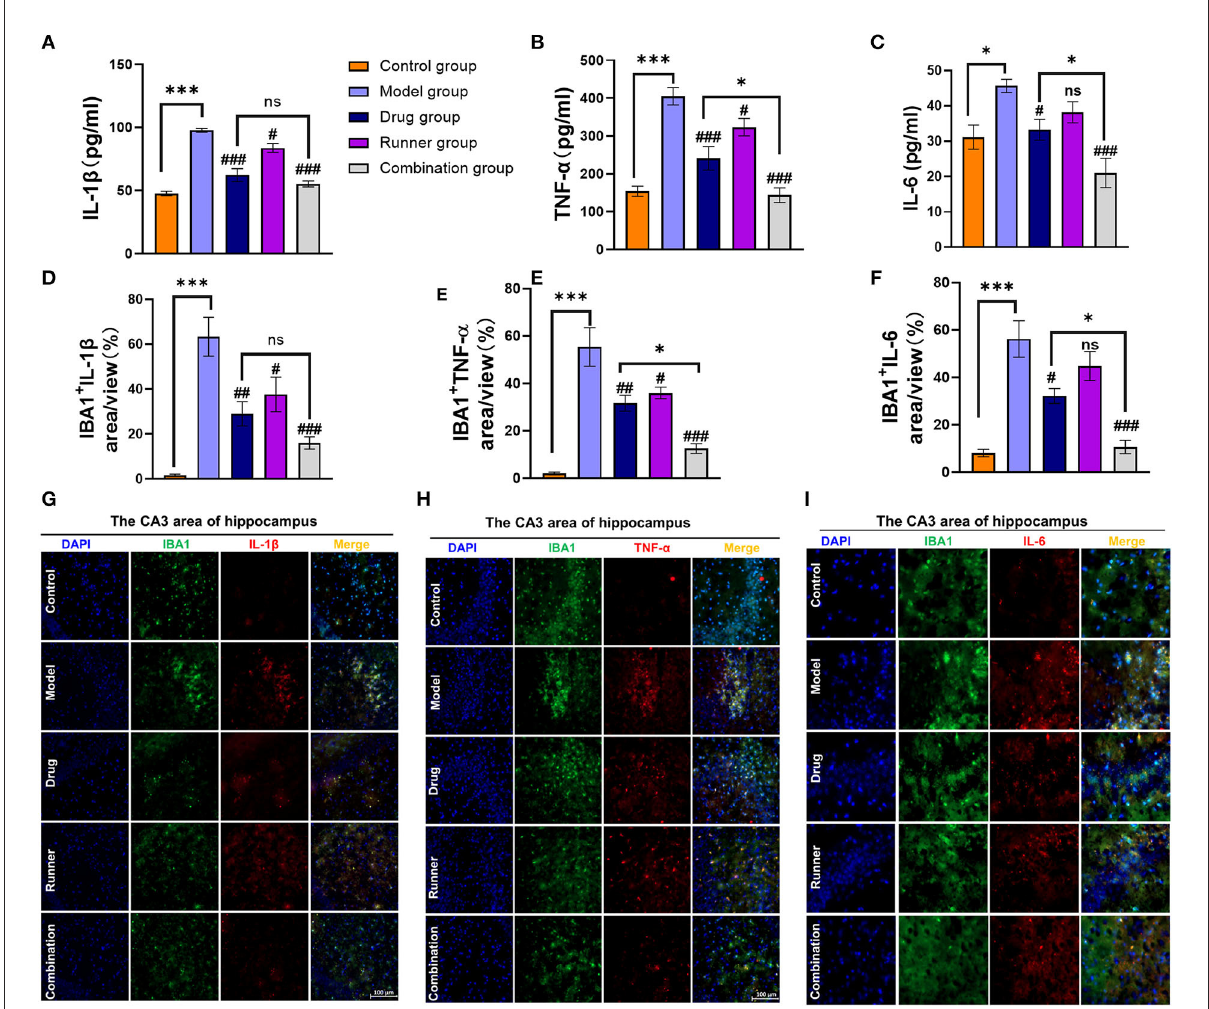
FIGURE6 LE-VPA blocked the activation of microglial cells and the release of inflammatory factors. (A–C) ELISA analysis of secreted TNF- α , IL-1 β , and IL-6 levels in control and four different treatment groups with epilepsy. (D–F) Quantitative analysis of percentage of IBA1 + IL-1 β -, IBA1 + TNF- α -, and IBA1 + IL-6-positive area. (G–I) Immunofluorescent staining of IBA1 and IL-1 β , IBA1 + TNF- α , and IBA1 + IL-6 in the hippocampal CA3 area (scale bar, 100 µ m). The data were expressed as the mean ± SEM. ns > 0.05, * P < 0.05, *** P < 0.001; # P < 0.05, ## P < 0.01, ### P < 0.001, compared with model group (two-way